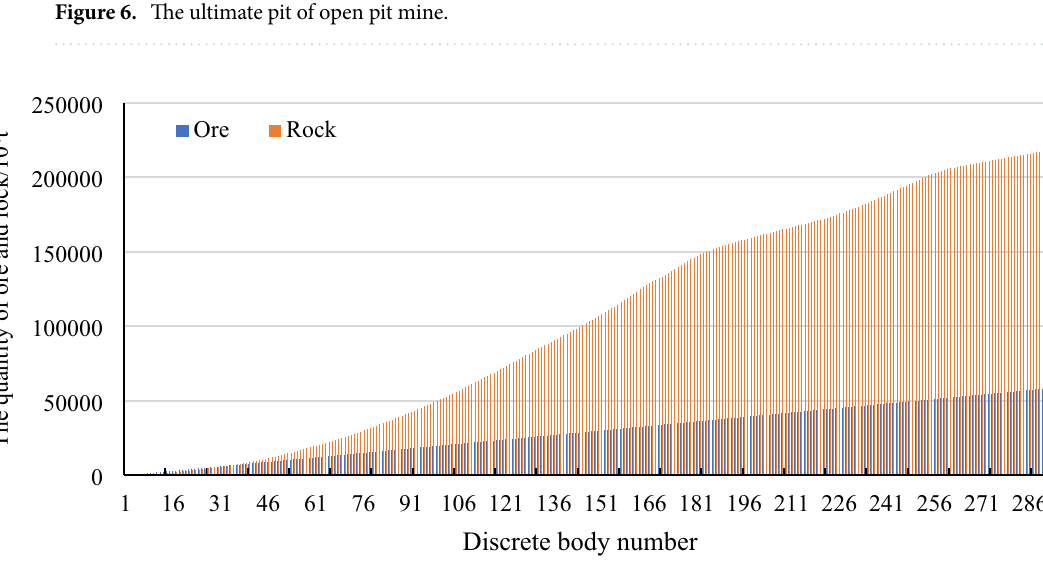
Figure 7. Discrete body